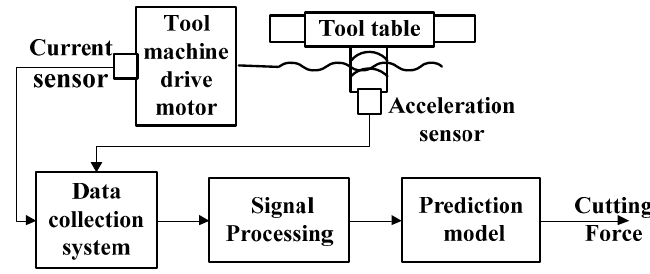
Figure 1. Schematic illustrations of current-sensor-based cutting force sensing technique.